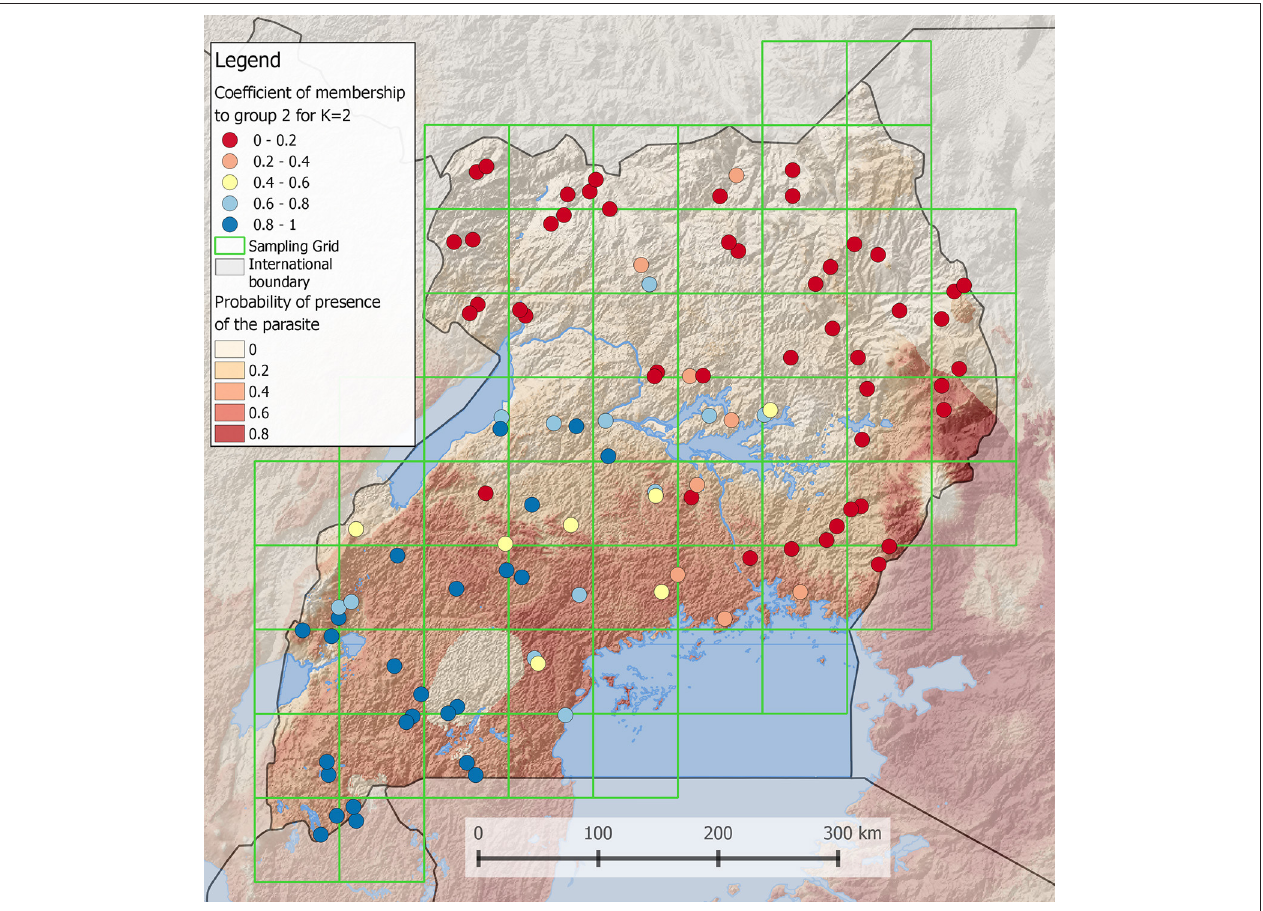
FIGURE 2 | Coefficient of membership to a genetic group of Ugandan Cattles (Stucki, 2014). Using the software admixture (Alexander et al., 2009), the most likely number of populations was found to be 2. In this case, it is possible to display the membership coefficient of each individual to one of the two populations. To do so, a gradient obtained from http://colorbrewer2.org is passing through a neutral hue to contrast the two populations. The order of layers in the legend is the same as in the map. In the background, a grid layer of probability of presence of a parasite is shown. A semi-transparent shaded relief is also displayed to reveal the topography. Lakes and international boundaries are overlaid on these raster layers. Ugandan boundaries are highlighted by darkening surrounding